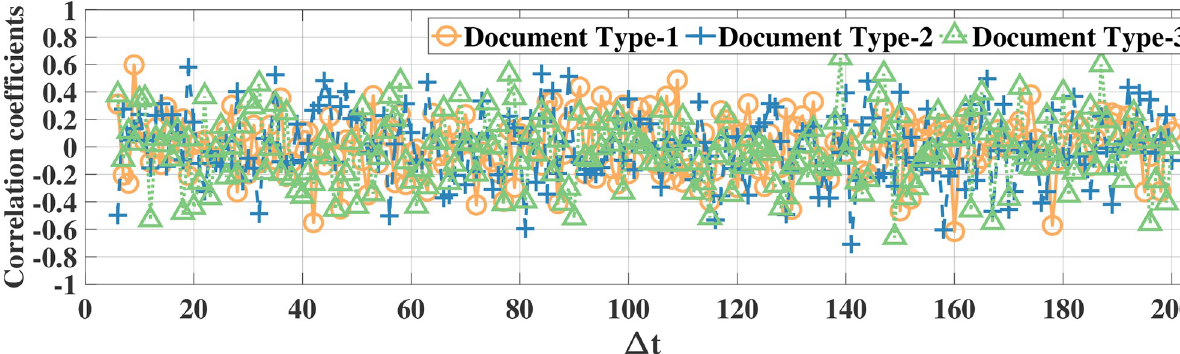
Fig 4. Correlation coefficients of the difference signals of feature ratio large saccade in the MPIIDPEye dataset. The values are calculated over a time difference of Δ t (Each time step corresponds to 0.5s) w.r.t. the samples at the fifth time instance.